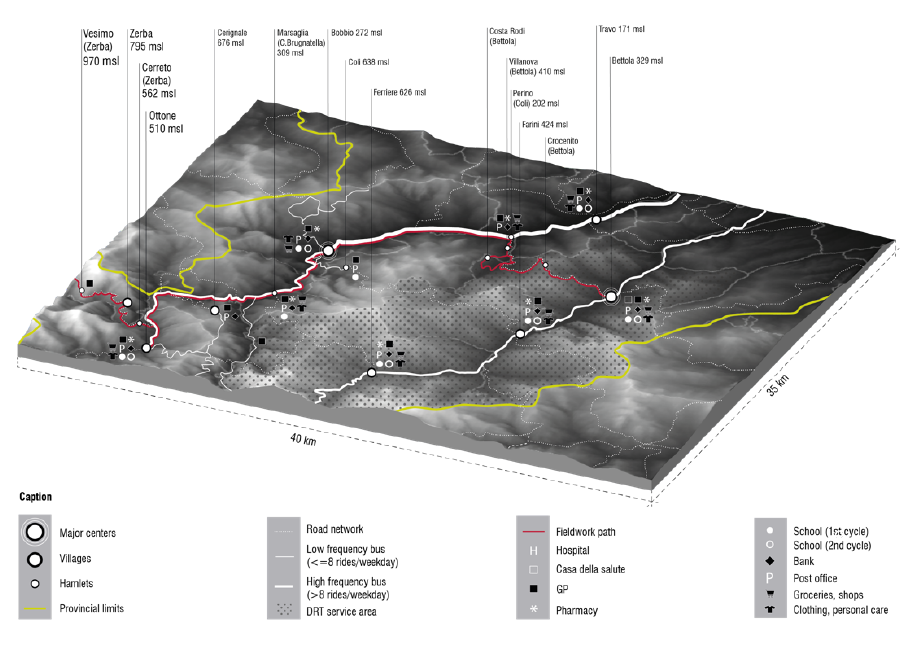
Figure 2: The System of Val Trebbia and Val Nure with the main centers, the villages, the mountain hamlets, and the system of